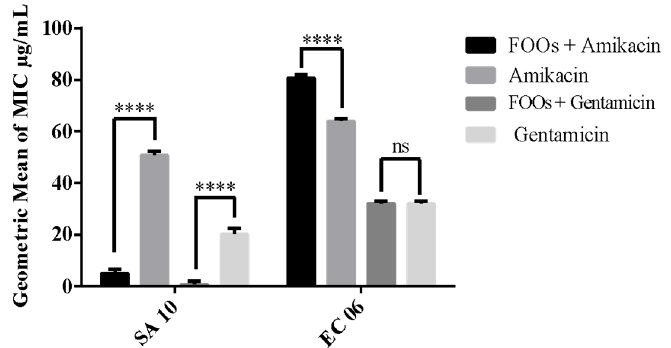
Figure 1. Effect of fixed oil of Orbignya speciosa (FOOs) on the activity of aminoglycoside antibiotics against multiresistant strains of Staphylococcus aureus (SA) and Escherichia coli (EC). Values represent the geometric mean ± M.S.E. (mean standard error). One-way ANOVA, followed by the Bonferroni test. **** statistically significant value with p < 0.0001 antibiotic + FOOs vs. control (antibiotic); ns: not statistically